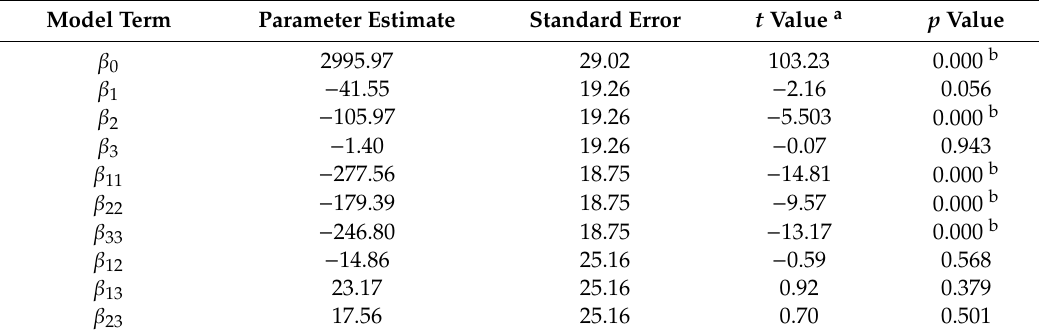
Table 6. Significance of the coe ffi cients in the empirical